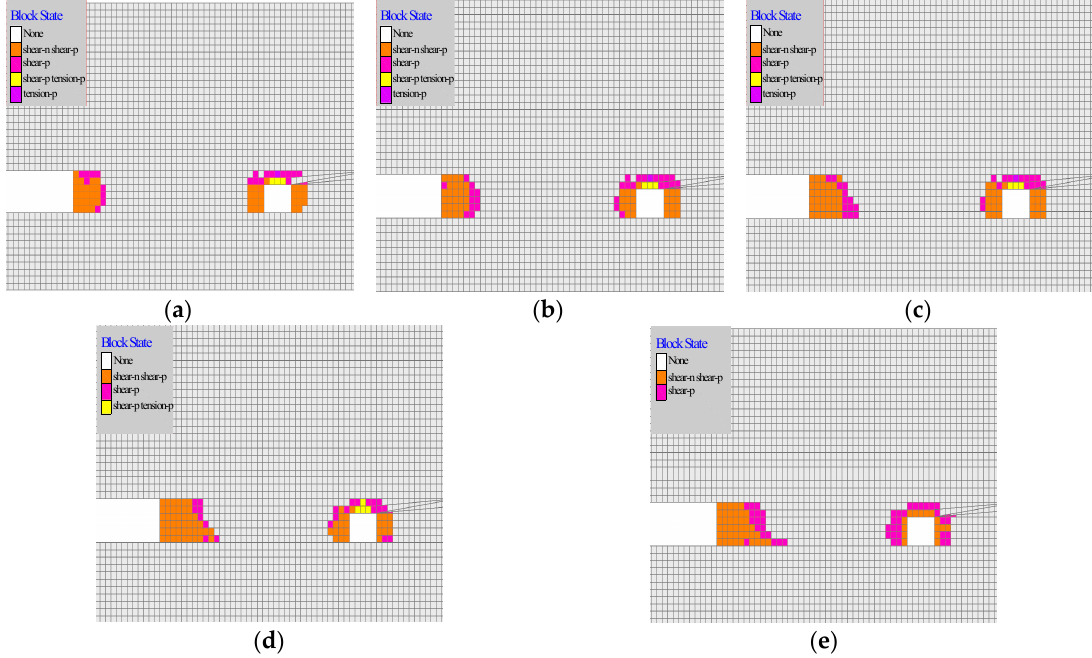
Figure 14. Schematic diagram of the plastic zones during the excavation of the previous coal face